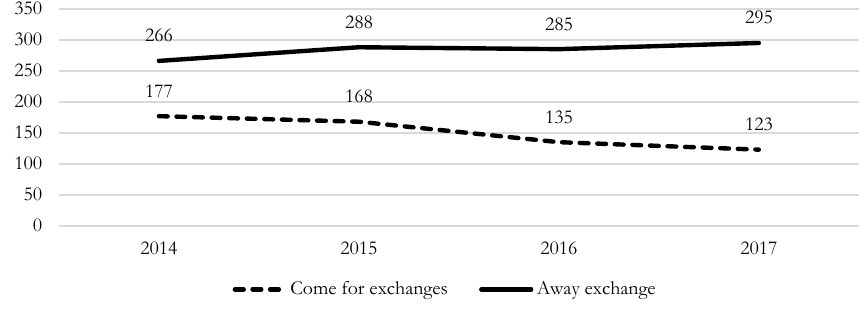
Fig. 9 – International exchange students at MRU. Source: Mykolas Romeris University